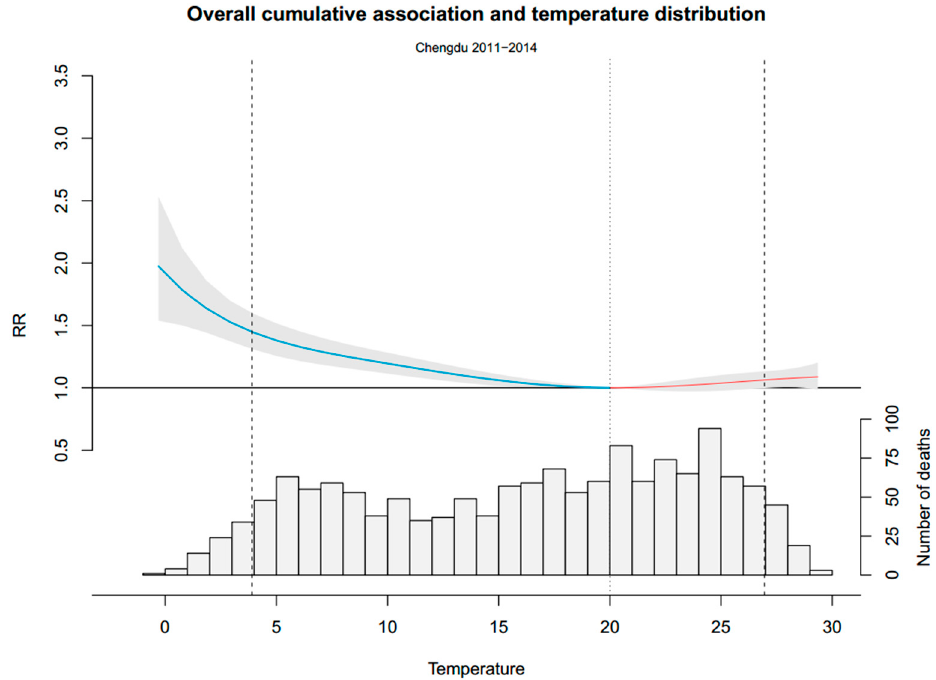
Figure 3. Overall cumulative exposure-response association in Chengdu City. The blue part of the curve is the exposure-response association (with 95% empirical confidence interval, shaded grey) of cold, and the red one presents the heat. The dotted line is minimum mortality temperature and the dashed lines are the 2.5th and 97.5th percentile. RR represents as the relative risk.